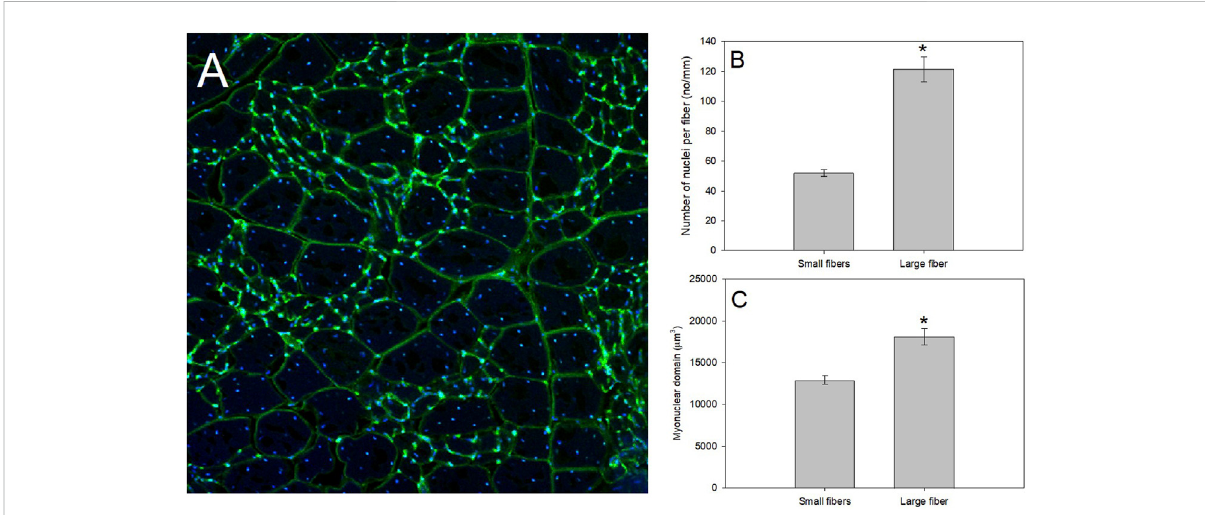
FIGURE 3 A productive model system to study regulation of muscle fi ber size as whole-animal energetics change for birds is that of the pectoralis of mourningdoves. (A) After fi xingthepectoralismusclein4%paraformaldehyde,weplaced fi xedmuscletissuein25%sucrosefor24 htocryo-protect the samples. Tissues were then fl ash frozen in isopentane cooled in liquid nitrogen, mounted at resting length in Optimal Cutting Temperature (O.C.T.) compound and allowed to equilibrate to − 19 ° C in a Leica 1800 cryocut microtome before sectioning. Sections were cut at 30 μ m, pickeduponslides,air-driedatroomtemperature,stainedwitha250 μ g/mlsolutionofwheatgermagglutinin(WGA)labeledwithAlexaFluor488(in green), and 4 ′ ,6-diamidino-2-phenylindole (DAPI; in blue), for 30 min, and rinsed in avian ringer ’ s for 60 min. WGA is a lectin that binds to glycoproteins on the basement membrane of the fi ber sarcolemma, and effectively outlines the fi ber periphery to allow measurements of fi ber size, whereas DAPI irreversibly binds to nuclei. Stained slides were examined with an Olympus Fluoview 1000 laser fi lter confocal microscope, and pictures were taken at a magni fi cation of ×20. Mourning dove pectoralis muscle contain a population of small muscle fi bers with a myonuclear domain (MND) surrounded by a population of large muscle fi bers. (B,C) Using data from Jimenez and De Jesus (2021b), we isolated the number of nuclei per fi ber and MND of N = 4 mourning doves ( N = 135 small fi bers and N = 63 large fi bers). Using a one-way ANOVA, the small fi